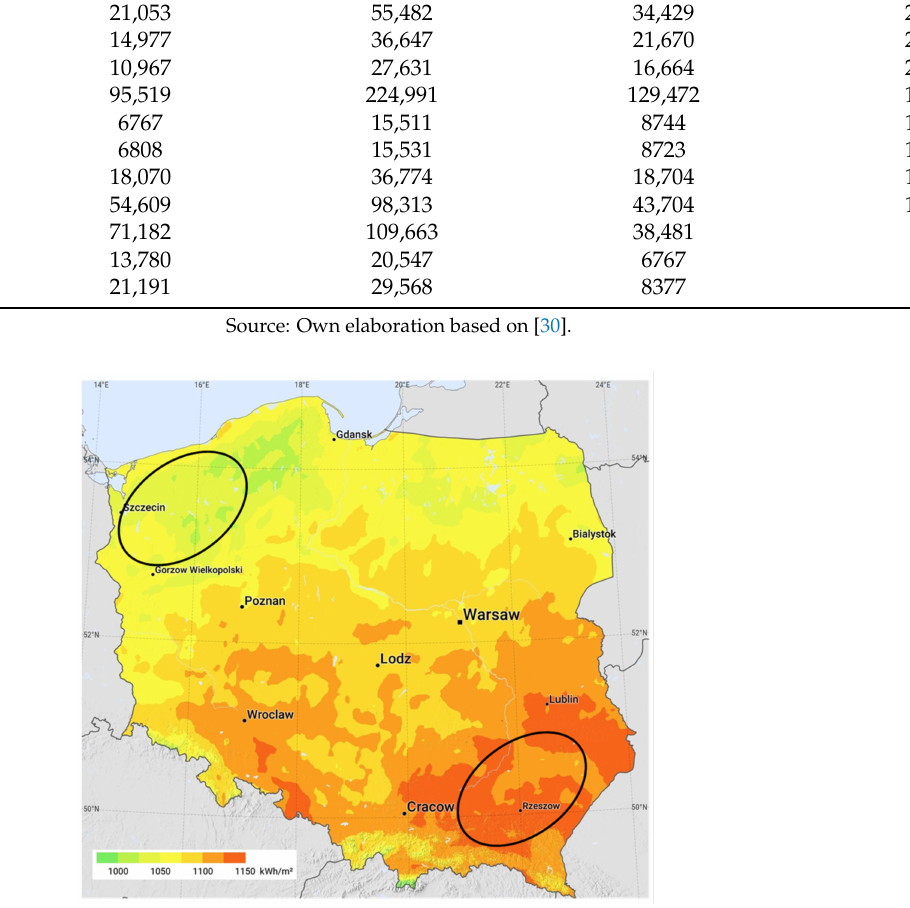
Figure 6. Insolation map of Poland with study areas marked. Source: Own elaboration based on